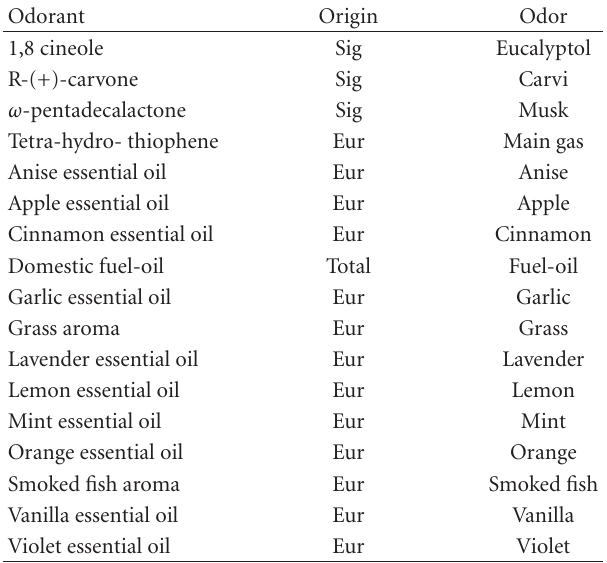
Table 1: List of odorants, origins, and odors. Eur: Euracli; Sig: